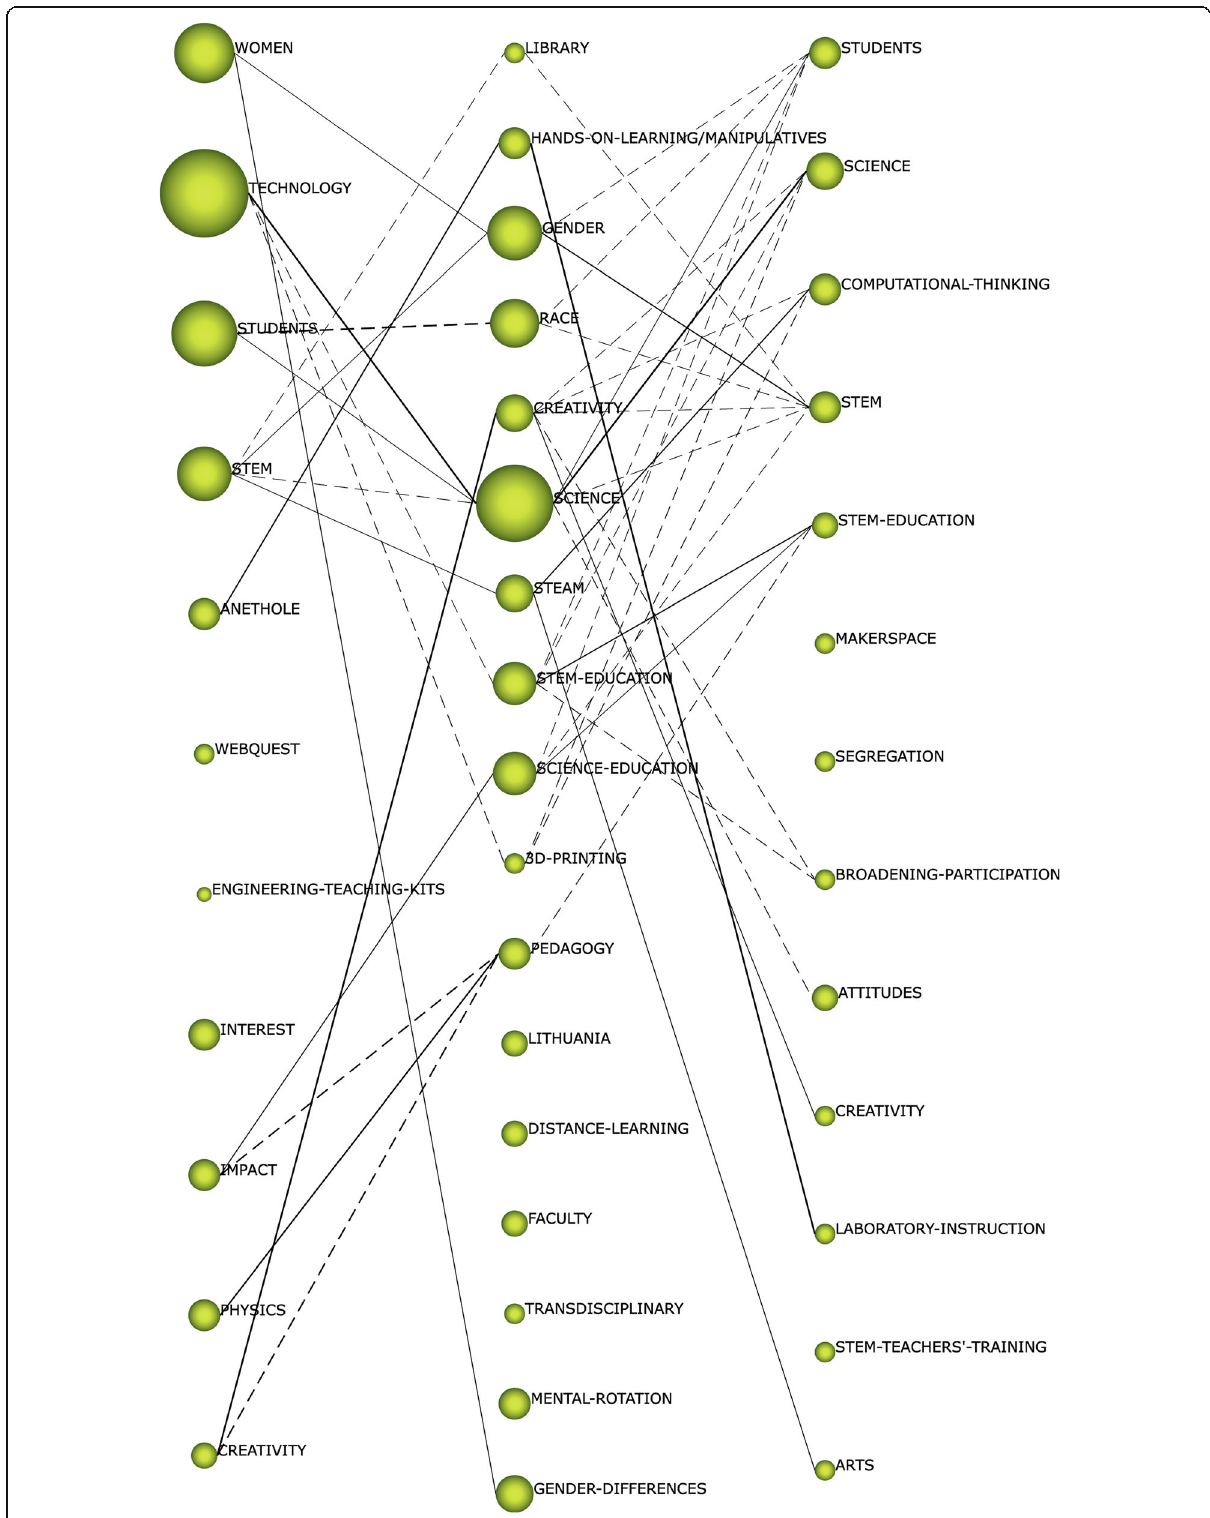
Fig. 8 Thematic evolution by